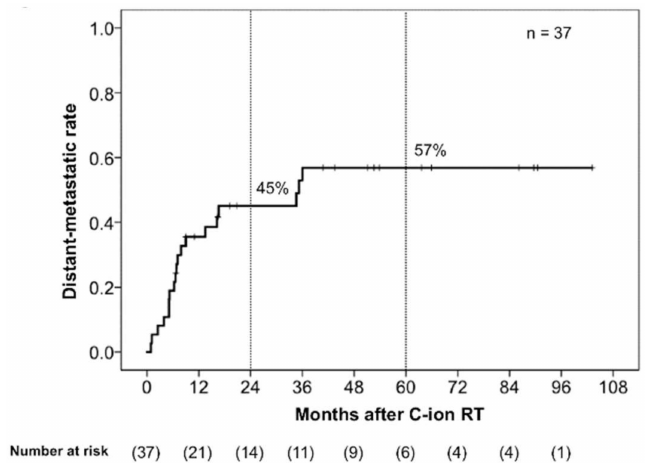
Figure 2. Kaplan–Meier curve of the distant metastatic rates. The numbers at risk are shown below the figure.